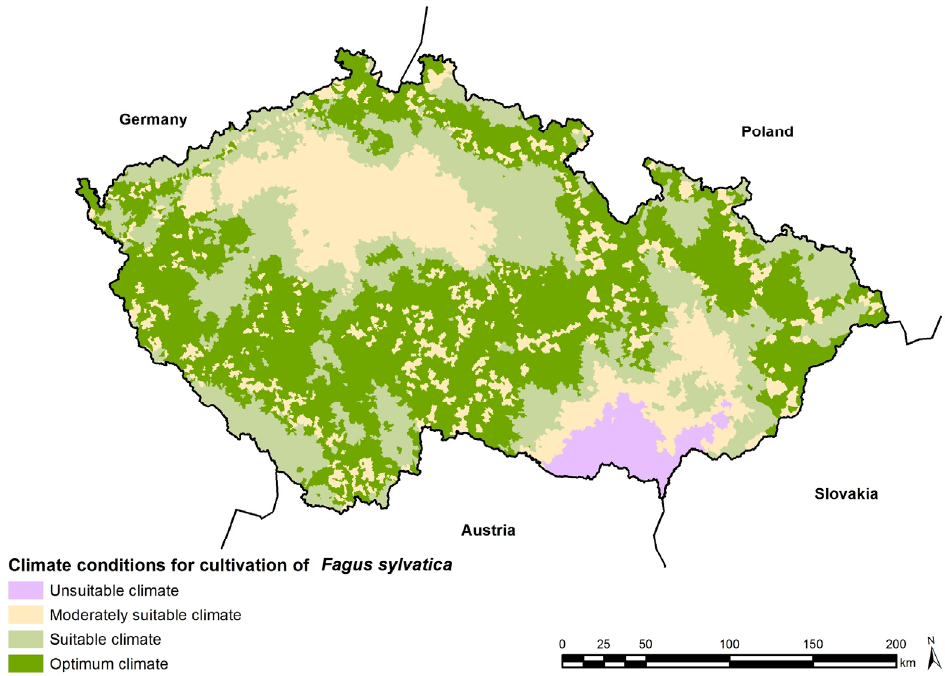
Figure 3. Visualization of predicted distribution of climate conditions for the European beech in the Czech Republic in 2030.